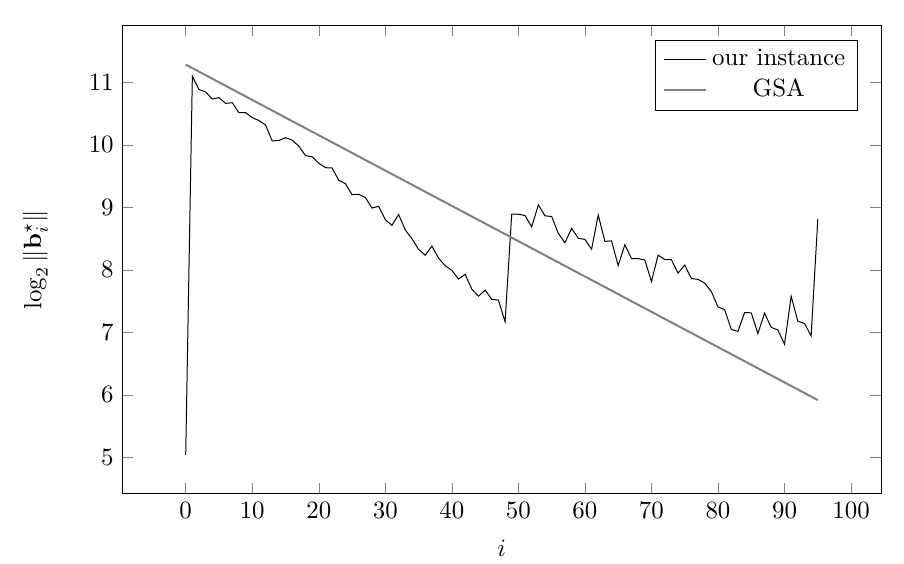
Figure 3: Length of Gram-Schmidt vectors in q -ary lattice derived from negacyclic inverse NTT at dimension 32 using parameters ‘ = 7 , θ =